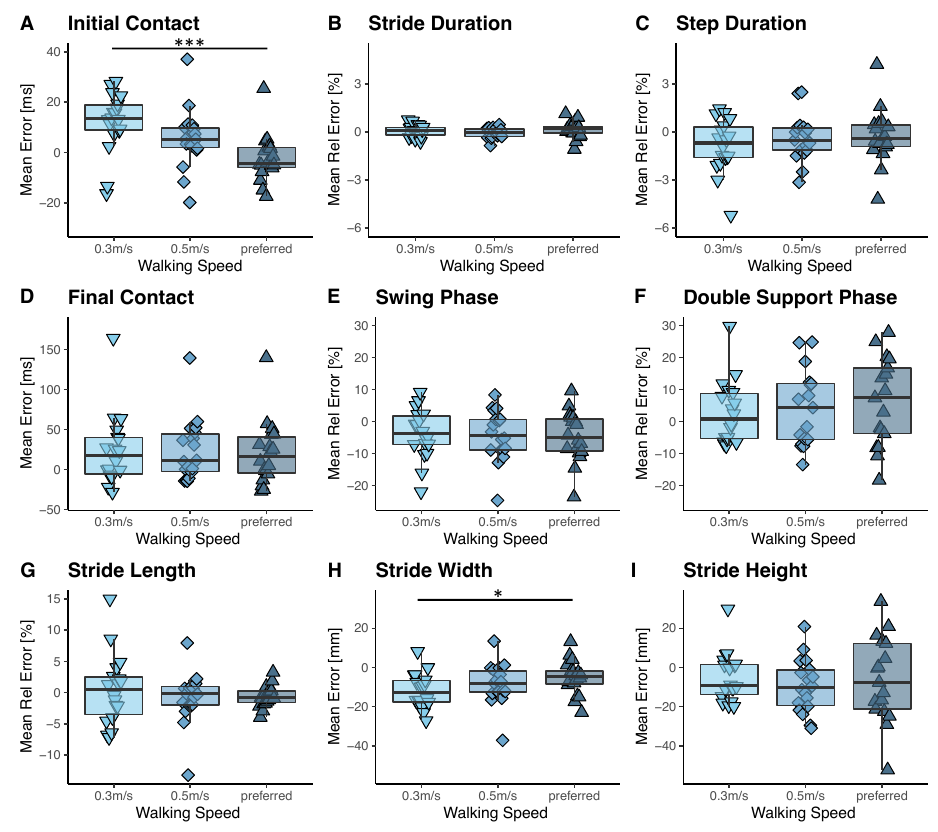
Figure 5. Mean error and mean relative error between ground truth and sensor-derived gait pa- rameters for SCI patients walking on a treadmill at 0.3 m/s, 0.5 m/s, and their preferred speed. Boxes show 1st to 3rd quartile and the whiskers extend from the hinges to the largest/smallest value within 1.5 interquartile range. The black bar in the boxes displays the median. Significant differences between the different speed levels are indicated by * ( p < 0.05) and *** ( p <